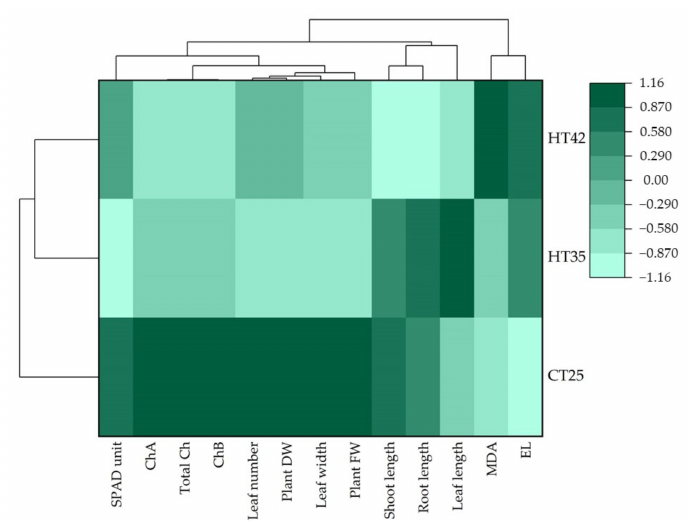
Figure 4. Hierarchical cluster analysis and heatmap explaining the responses of KDML105 seedlings on heat stress at different levels (25, 35 and 42 ◦ C) (ChA = chlorophyll a; ChB = chlorophyll b; DW = dry weight; FW = fresh weight; MDA = malondialdehyde; EL = electrolyte leakage).